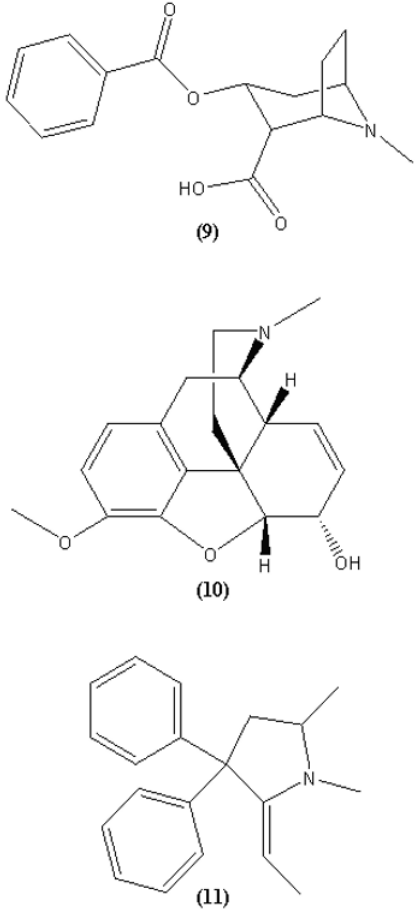
Figure 4. The molecular structures of benzoylecgonine (BE, 9 ), codeine ( 10 ) and 2–ethylidene–1,5–dimethyl– 3,3–diphenylpyrrolidine (EDDP, 11